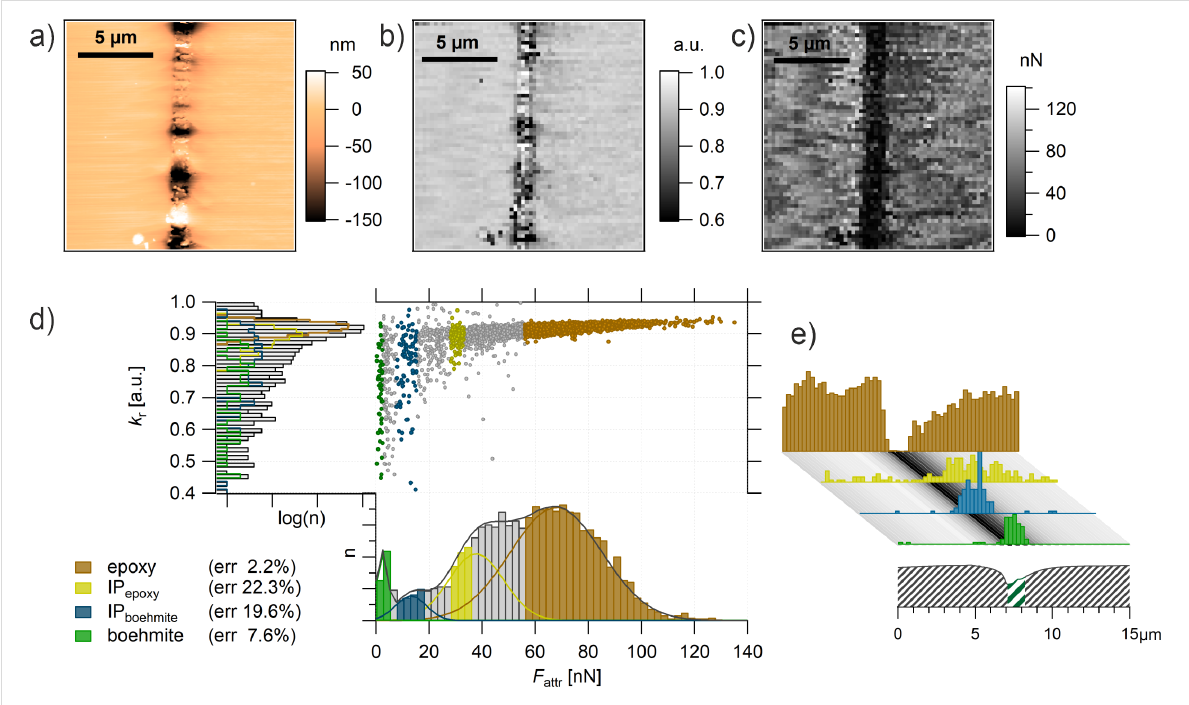
Figure 5: (a) AFM tapping-mode topography. Epoxy and boehmite phases can be distinguished by features that varied in height. (b) k r and (c) F attr AFM FDC maps (80 × 80 points). (d) Property domain of AFM FDC with k r histogram (top left), F attr histogram (bottom right), and k r / F attr diagram (top right). The k r histogram is deconvoluted with four Gaussian fits assigning the chemical structures epoxy (brown), IP epoxy (yellow), IP boehmite (turquoise), and boehmite (green) to individual measuring points (see also the k r / F attr diagram). (e) Assignable measuring points in each column were summed up, leading to a histogram of each species as a function of the distance to the boehmite structure (topography profile at the bottom). The measurements were performed with the tip C.